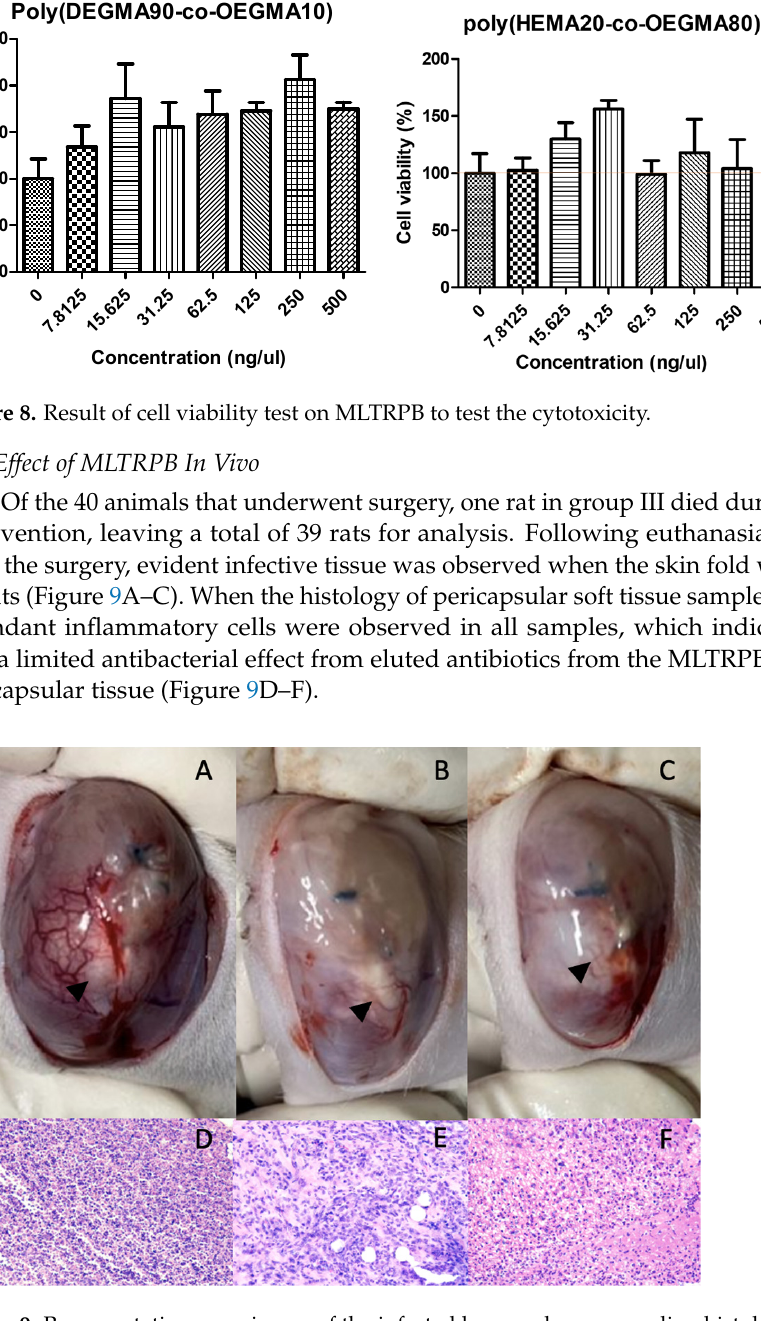
Figure 8. Result of cell viability test on MLTRPB to test the cytotoxicity.